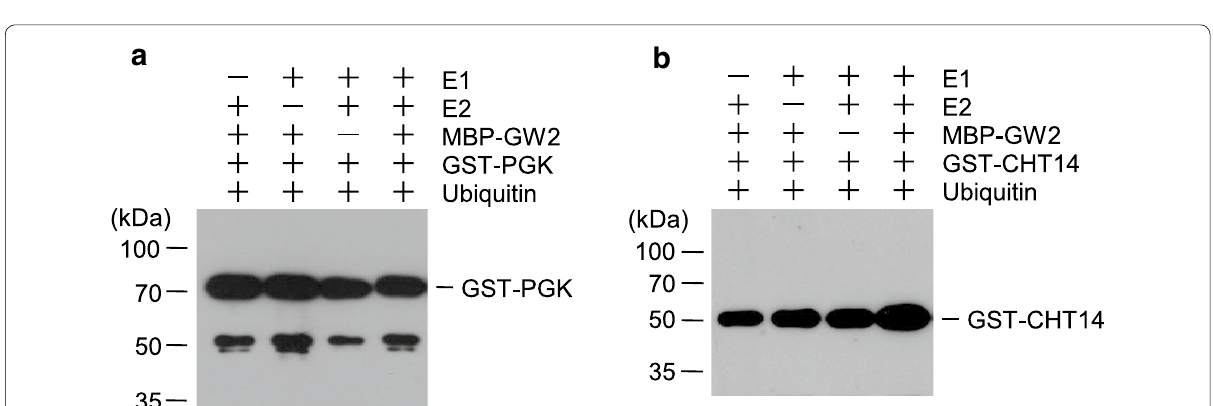
Fig. 3 GW2 does not ubiquitinate PGK and CHT14 in vitro. MBP-GW2, GST-PGK, and GST-CHT14 were overexpressed in E. coli and purified with amylose or glutathione affinity columns. Ubiquitination of GST-PGK ( a ) or GST-CHT14 ( b ) was examined in the presence or absence of rabbit E1, UbcH5b (E2), MBP-GW2 (E3), and His 6 -ubiquitin. PGK and CHT14 proteins were detected by western blotting using anti-GST